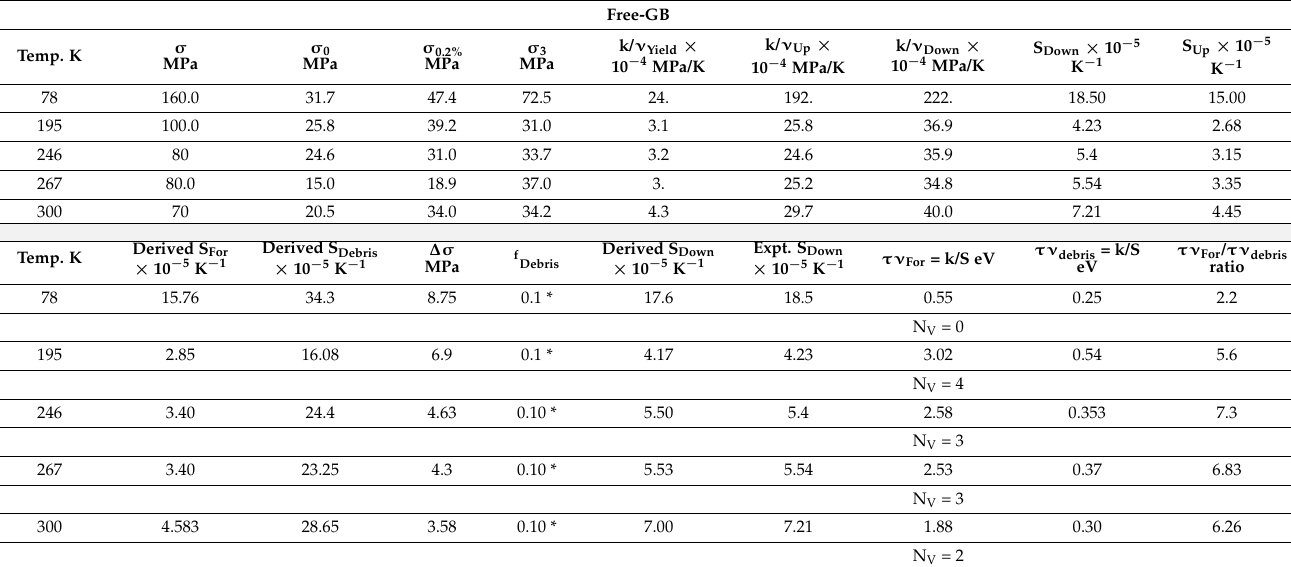
Table 2. Parameters to characterize linearized Haasen plot for Free-GB Al and predictions.